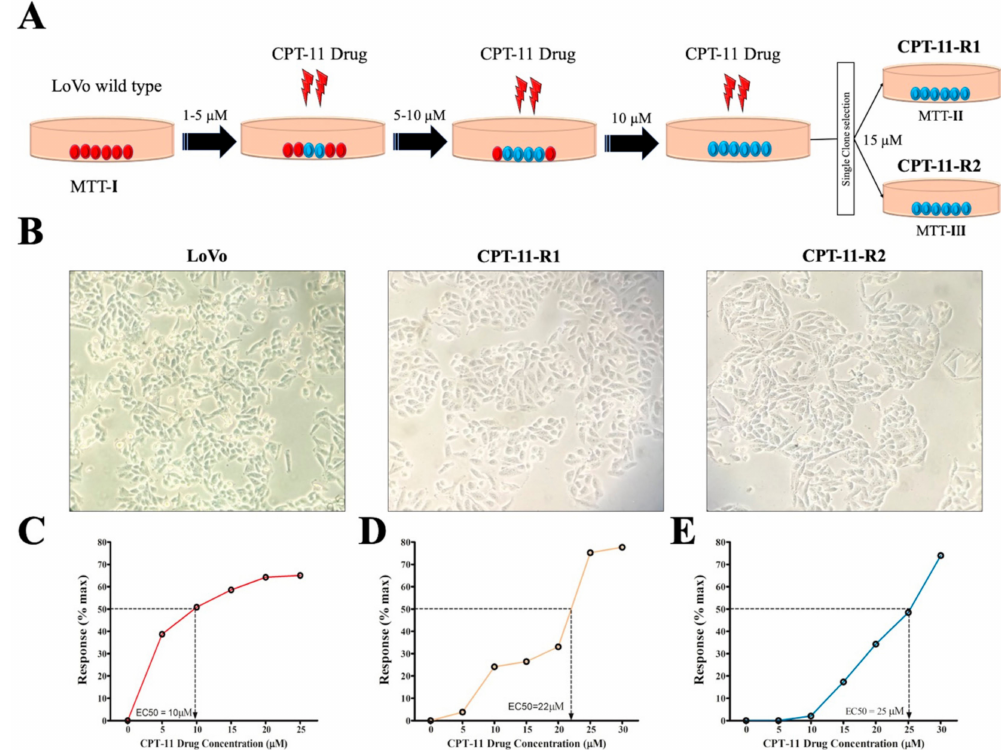
Figure 1. Generation of drug-resistant cell lines. A drug-resistant stable cell line developed from the LoVo cell line. ( A ) Drug-resistant stable cell line generation through stepwise challenge using CPT-11 (irinotecan) in the LoVo colon cancer cells for 6 months. ( B ) Morphology changes in the LoVo cells and CPT-11-R clones (20 × ). Drug response was assessed using cell proliferation (MTT) assay. ( C ) Treatment with 10 µ M CPT-11 drug generated EC 50 values in the LoVo cell line at 48 h. ( D , E ) 25 µ M CPT-11 drug treatment to reach the EC 50 value in CPT-11-R-resistant clones at 72 h. The results are presented as mean ± standard error of the mean ( n =